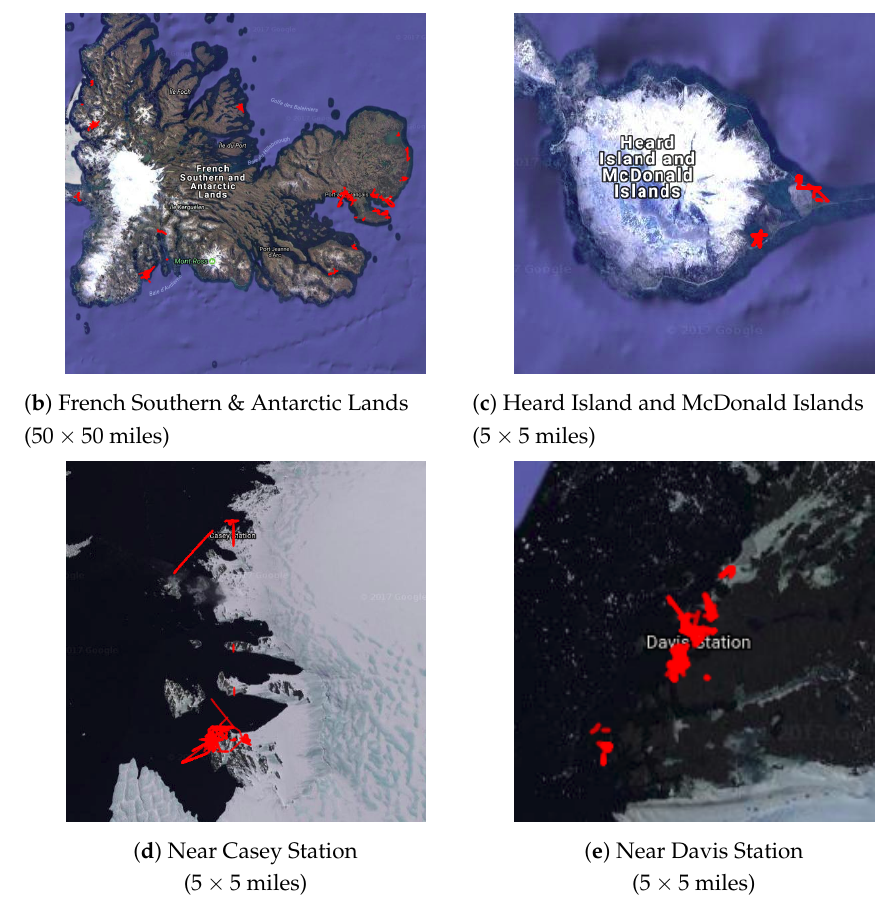
Figure 4. Locations of the representative trajectory segments (Approximate area size), https://www. google.com/maps Map data c (cid:13) 2018 Imagery c (cid:13) 2018 NASA c (cid:13) 2018 Google Terms of